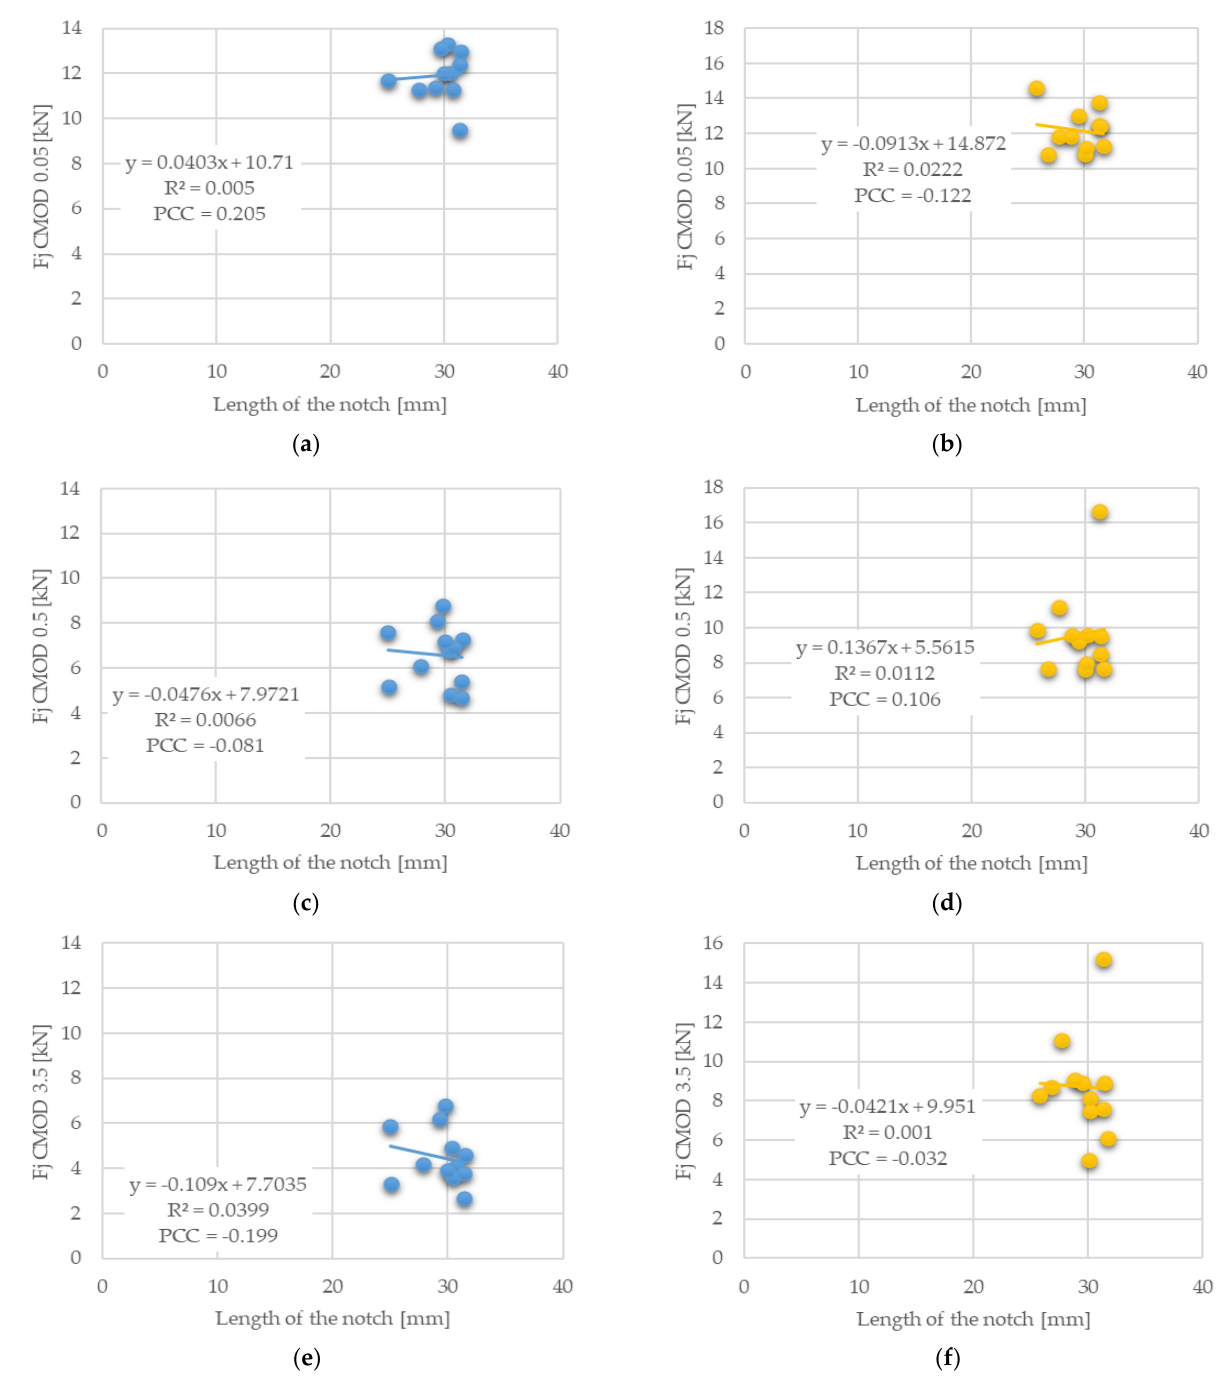
Figure 6. Width of the notch and load corresponding to CMOD 0.05 mm (limit of proportionality): fibre A ( a ), fibre B ( b ); CMOD 0.5 mm: fibre A ( c ), fibre B ( d ); CMOD 3.5 mm: fibre A ( e ), fibre B ( f ).